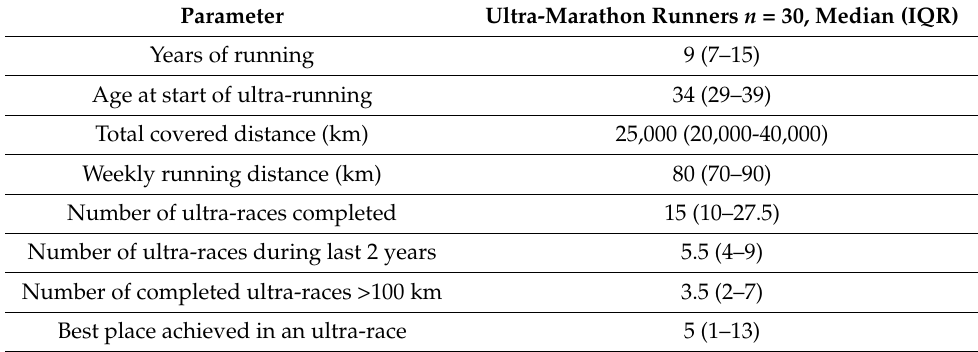
Table 1. Description of ultra-marathon runners. IQR—interquartile